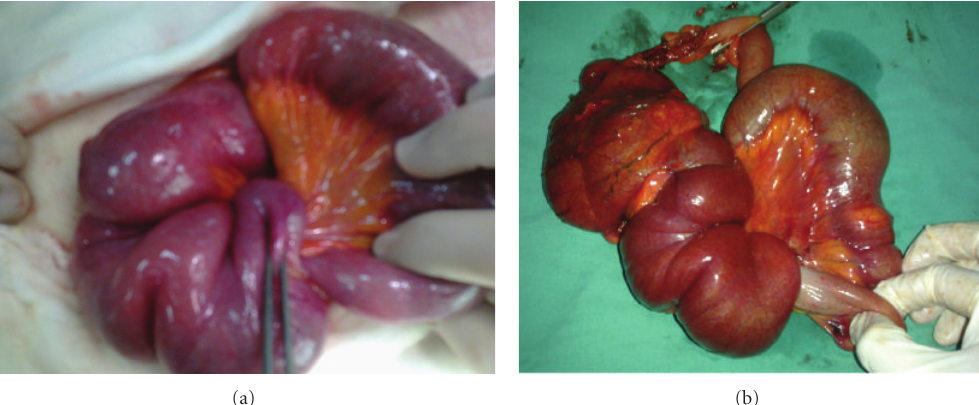
Figure 3: (a) Intraoperative and (b) postsurgical appearence of ileoceacal intususception. Ileocecal resection involving proximal half of the cecum and distal 30cm of terminal